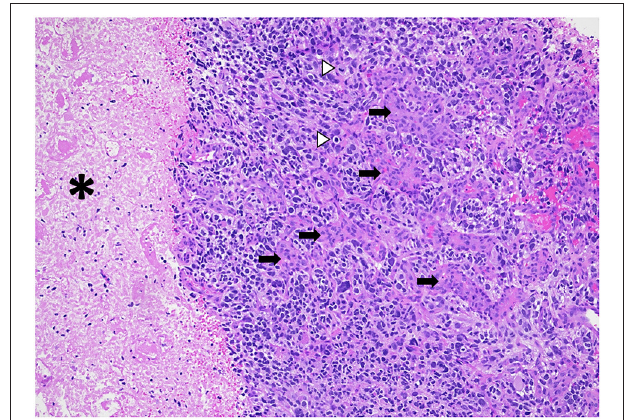
FIGURE 1 | Diffuse hemispheric glioblastoma, H3 G34 mutant (histologic “glioblastoma”) demonstrating high cellularity, nuclear pleomorphism, microvascular proliferation (arrows), necrosis (asterisks), and mitotic figures (arrowheads). HandE stain, 100x magnification.